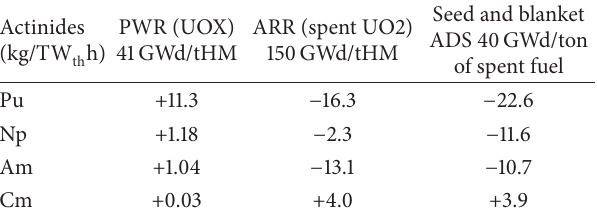
Table 3: Comparison of the actinide balance per ton of TW different systems.